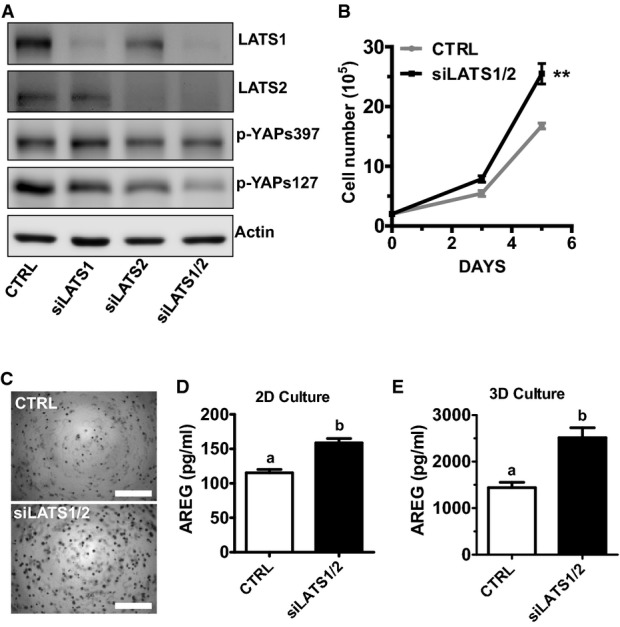
Effect of LATS1/2 on the growth of cancerous cervical cells
A Western blot analysis showed that LATS1/2 siRNAs successfully knocked down LATS1/2 and activated YAP in ME180 cells.

B Knockdown of LATS1/2 promoted proliferation of ME180 cells. Each point represents the mean ± SEM of five independent experimental results. **P < 0.01 (P = 0.0020).

C Representative images showing the anchorage-independent growth of ME180 with or without LATS1/2 knockdown (n = 5). Scale bar: 1 mm.

D, E The concentrations of AREG in 2D (D) or 3D hanging-drop (E) culture medium from ME180 control and LATS1/2 knockdown cells. Each bar represents the mean ± SEM of five independent experimental results. Bars with different letters are significantly different from each other [CTRL vs. siLATS1/2 in (D), P = 0.0017; CTRL vs. siLATS1/2 in (E), P = 0.0045].
Data information: Data in (B), (D), and (E) were analyzed for significance with unpaired t-test in GraphPad Prism 5 with Welch’s correction.